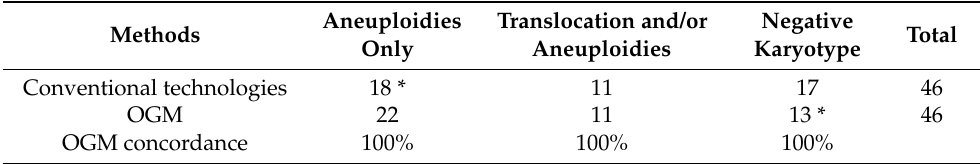
Table 5. Result comparison between OGM and conventional